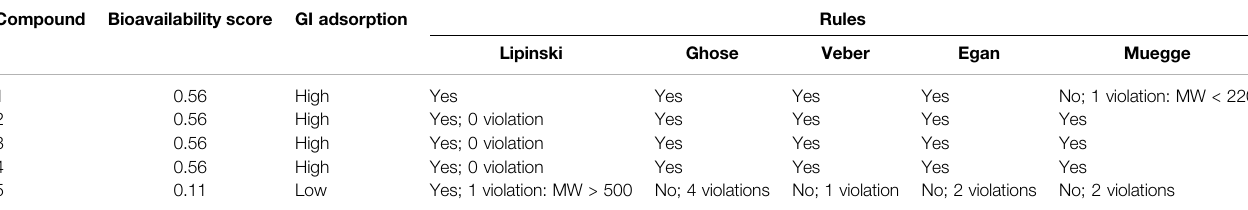
TABLE 1 | Drug-likeness parameters of the analyzed compounds. Predictions were obtained after introducing SMILES structures in the SwissADME web server. Bioavailability score, Gastrointestinal (GI) adsorption and the Lipinski ’ s, Ghose ’ s, Veber ’ s, Egan ’ s and Muegge ’ s rules de fi ne the drug-likeness score for each